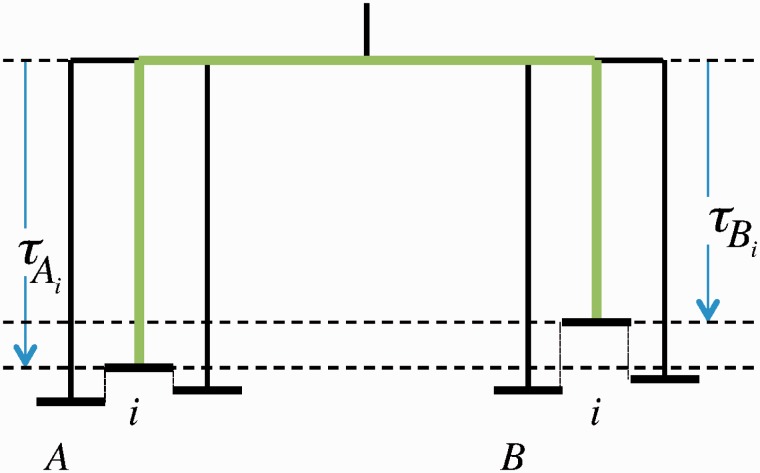
An example of the evolution of two divergent genomes. Different regions of the two species A and B evolve with different rates. The evolutionary distance separating two orthologous regions i (green path) is the sum of the evolutionary distance covered by this genomic region in both species since their split.